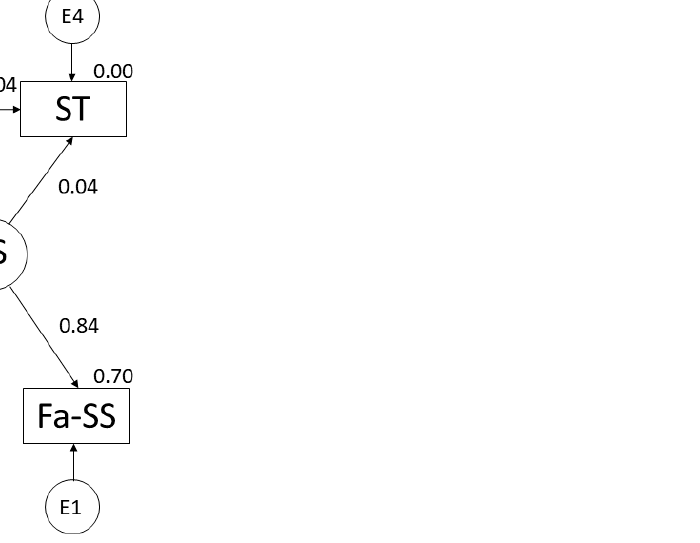
Figure 4. Theoretical model developed for females. Note: Physical Activity (PA); Social Support (SS); Screen Time (ST); Family Support (Fa-SS); Friends' Support (Fr-SS). Table 4. Structure of the theoretical model for females. Table 4. Structure of the theoretical model for females. Variable Associations